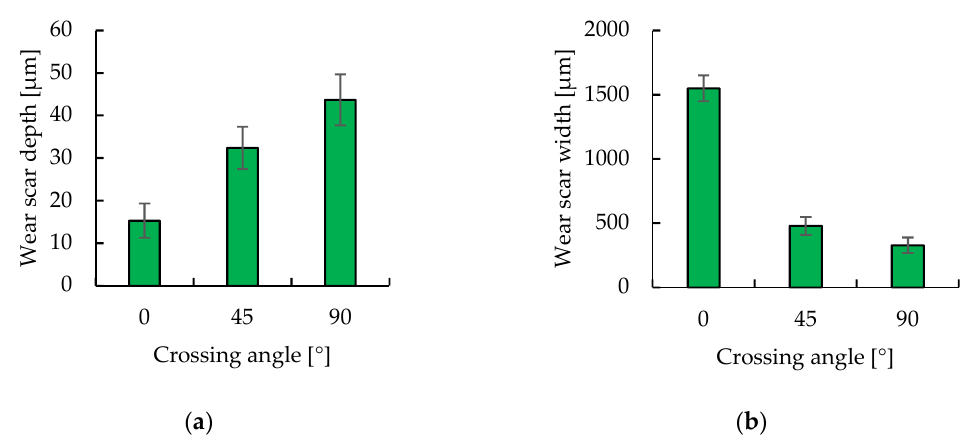
Figure 11. Quantitative characterization of the wear scar depth ( a ) and width ( b ) from 3D interferometry measurements corresponding to the crossing angles under analysis.